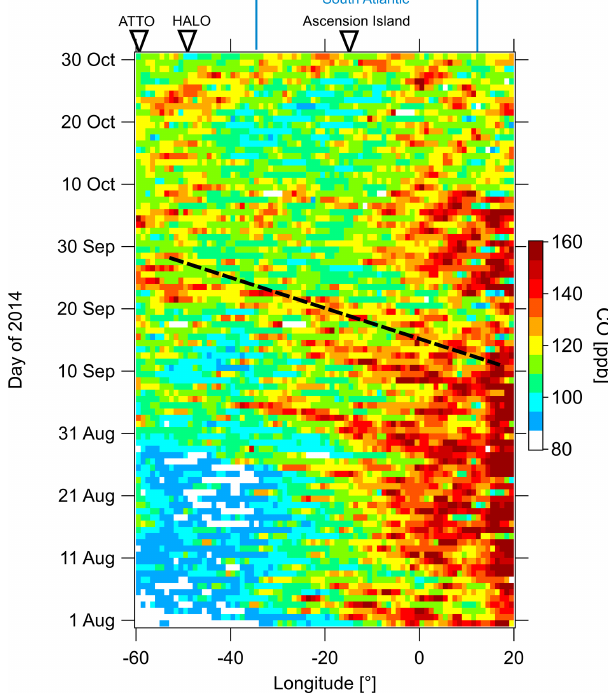
Figure 8. Hovmöller plot of the daily AIRS-derived carbon monox- ide (400 to 600hPa) distributed over the South Atlantic region (60 ◦ W to 20 ◦ E) from August to October 2014, averaged over the latitudinal band of 10 ◦ S to 5 ◦ N, corresponding to the region of interest (ROI) highlighted in Fig. 7a 1 . Several events of transat- lantic transport of aerosol from Africa towards South America can be identified. The black dashed line highlights a particularly strong plume originating around 10 September 2014 and arriving in the observational area of AC19 on 30